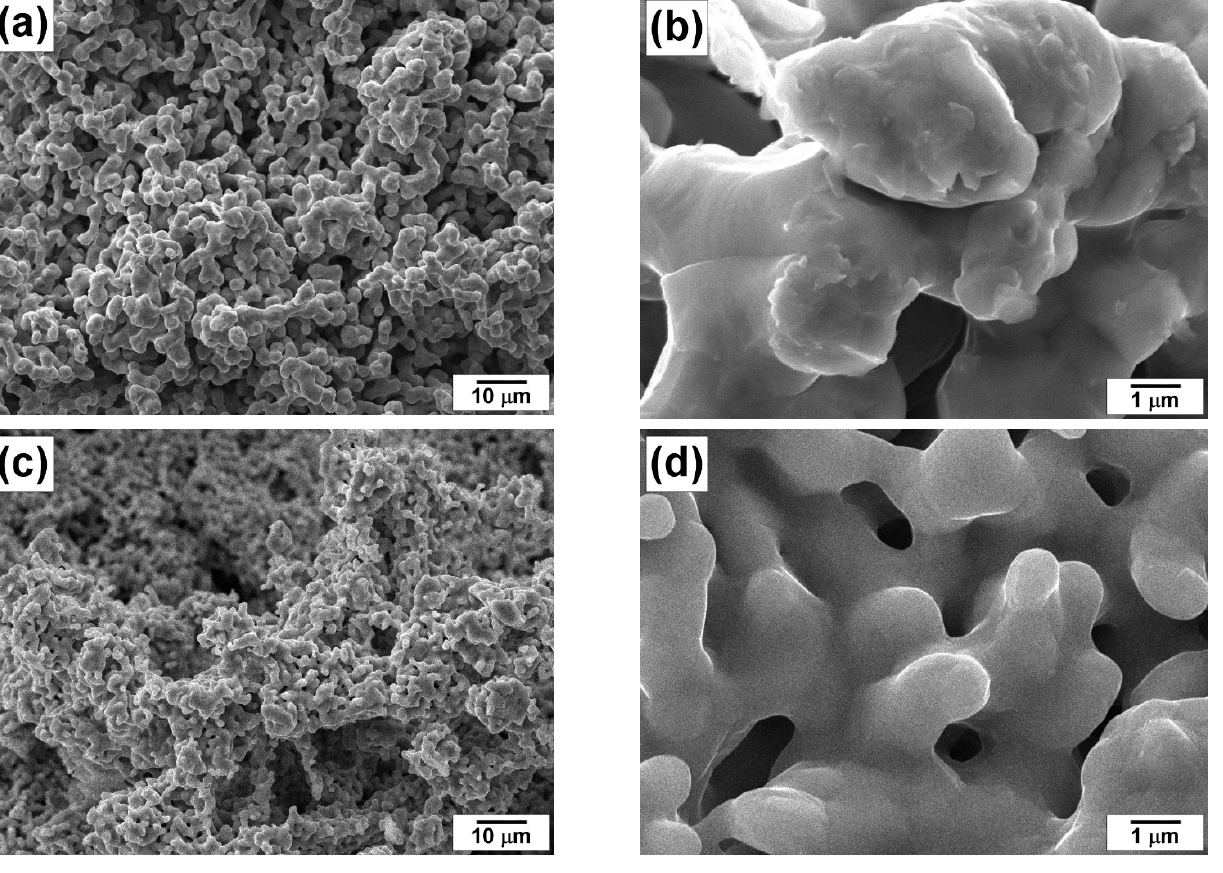
Figure 1. SEM images of the pristine samples prepared by co-precipitation and subsequent reduc- tive thermolysis: ( a , b ) 100Ni; ( c , d ) 96Ni-4W. thermolysis: ( a , b ) 100Ni; ( c , d )